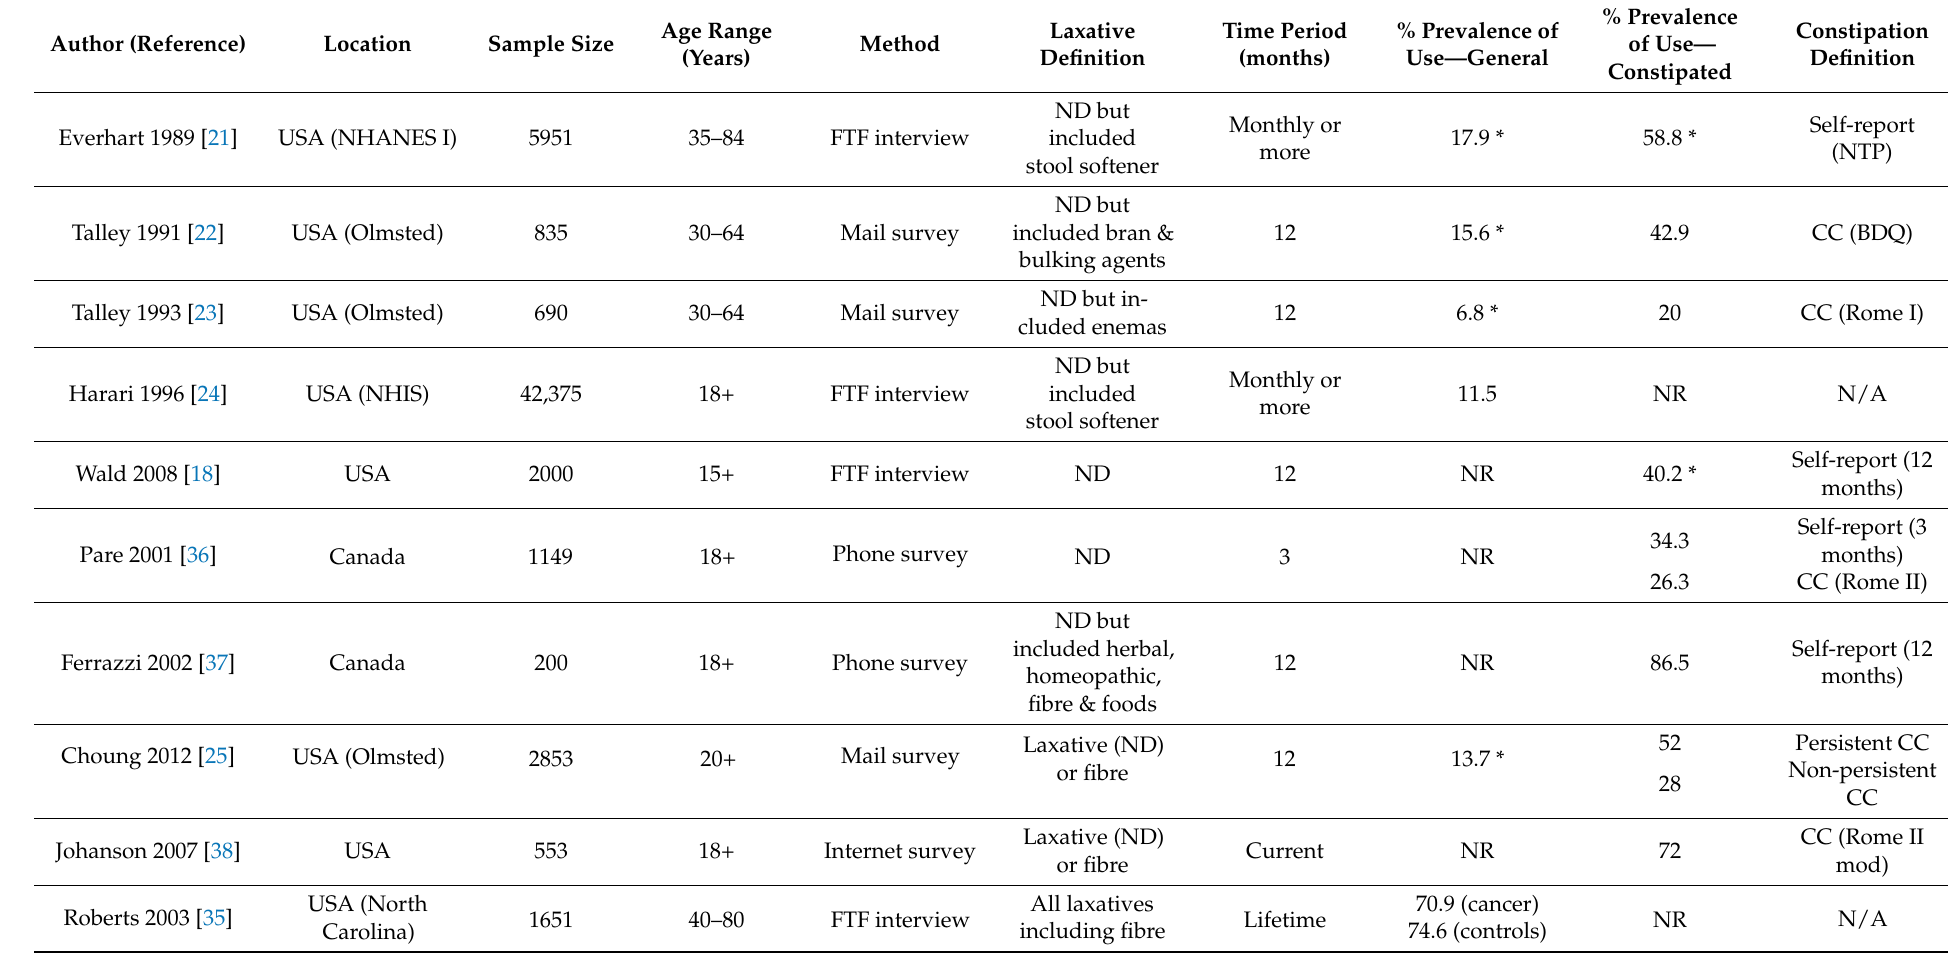
Table 3. Prevalence of laxative use in studies of community-dwelling adult